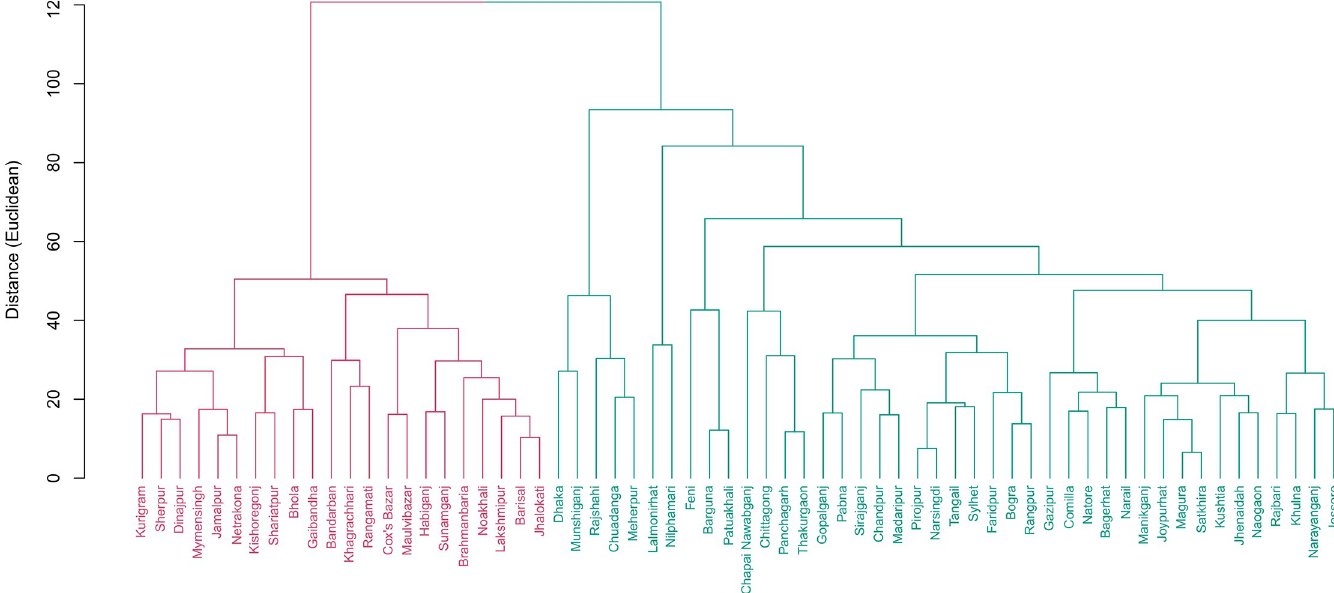
Fig 5. Cluster of districts based on reproductive health indicators. Two clusters were found. Cluster 1 include 42 districts while 22 districts were in cluster 2. Districts in cluster 2 have much lower antenatal care coverage (at least once by skilled health professional) (43.4% vs 58.7% nationally), lower percentage of skilled attendant at delivery (26% vs 43.5% nationally), nearly half on institutional delivery (16.1% vs 31%